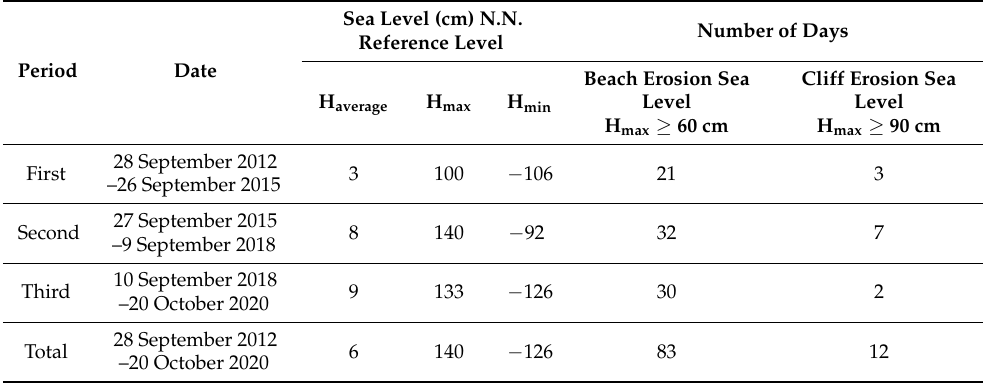
Table 4. Parameters of sea level in measurements period. Raw data source—Institute of Meteorology and Water